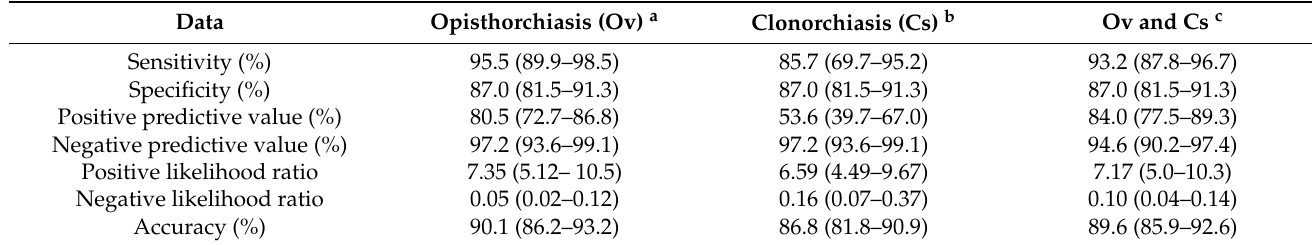
Table 2. Statistical analysis of the diagnostic values of the